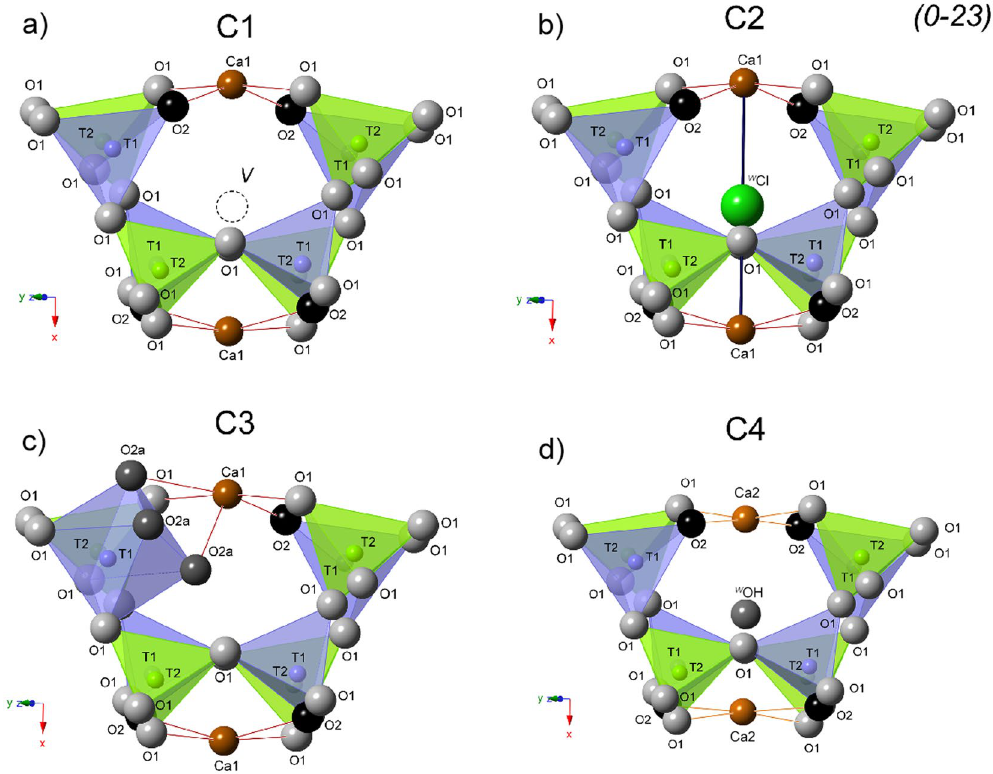
Figure 2. Four different cages of chlormayenite, inclusive extra-framework ions projected onto (0–23). The cage ( a ) C1 is unfilled, ( b ) C2 is filled by W Cl − (green sphere), ( c ) C3 in which one of the tetrahedral sites T 1 (violet) is hydroxylated, whereby O2a 3OH − replace one oxygen at O 2 (black spheres). The tetrahedral site T 2 (dark blue) connects four times to O 1 (dark gray spheres). ( d ) Cage C4 with OH group (gray sphere) situated at the W -site which drags the adjacent Ca 1 (brown spheres) into the cage center ( Ca